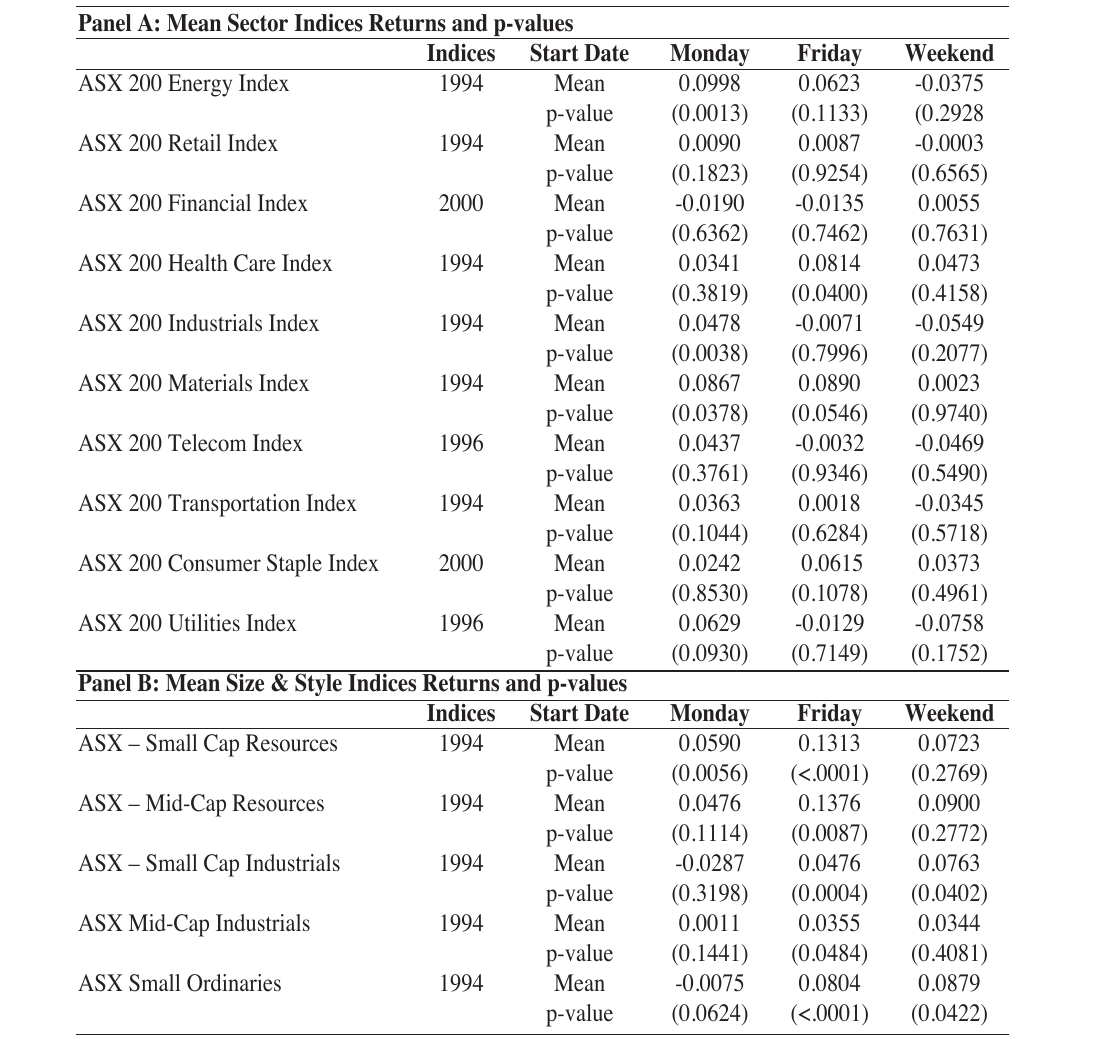
Returnsand Friday is the last trading day-of-the-week. The p-values for examining the mean (median) difference between the last and first trading day returns calculated through t-test (signed-rank test) are displayed in Table 3: Sector and Size Indices Panel A: Mean Sector Indices Returns and p-values Indices Start Date Monday Friday Weekend ASX 200 Energy Index